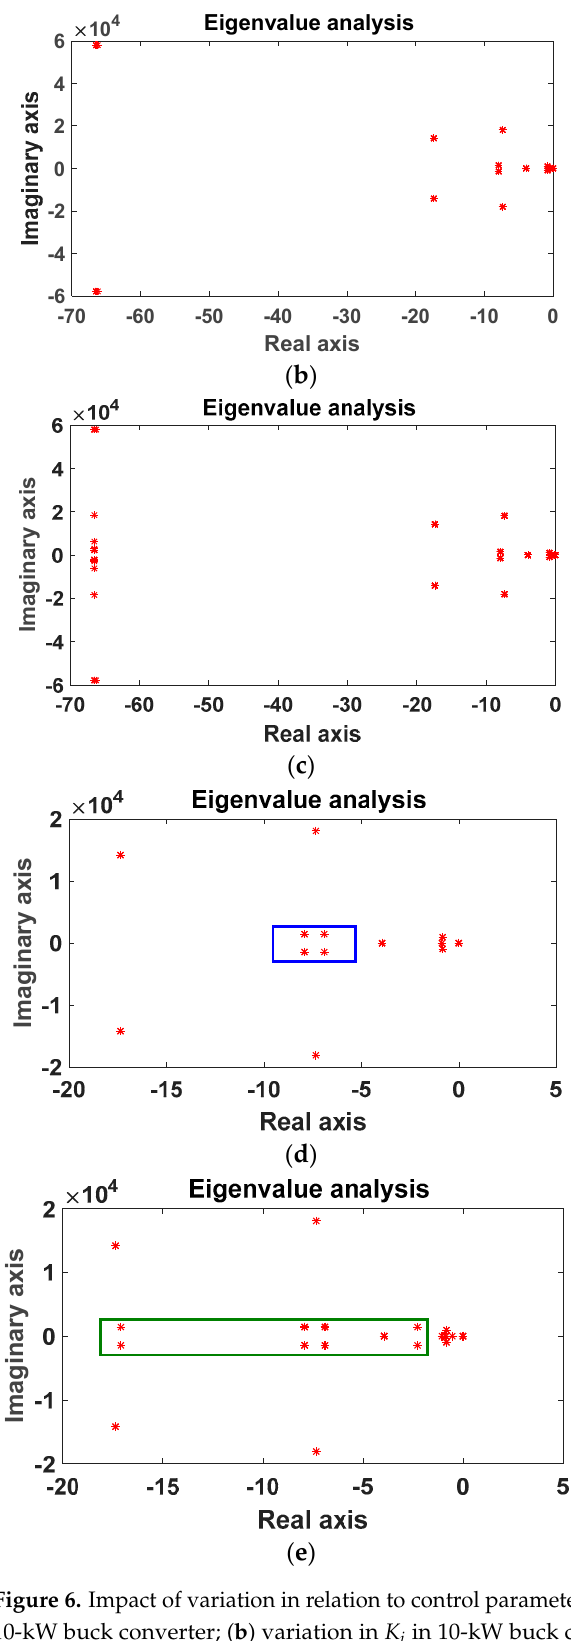
Figure 6. Impact of variation in relation to control parameters (buck converter). ( a ) Variation in K p in 10-kW buck converter; ( b ) variation in K i in 10-kW buck converter; ( c ) variation in both K p and K i in 10-kW buck converters; ( d ) incremental K p value for multiple units of converters; ( e ) arbitrarily selected controller parameter.